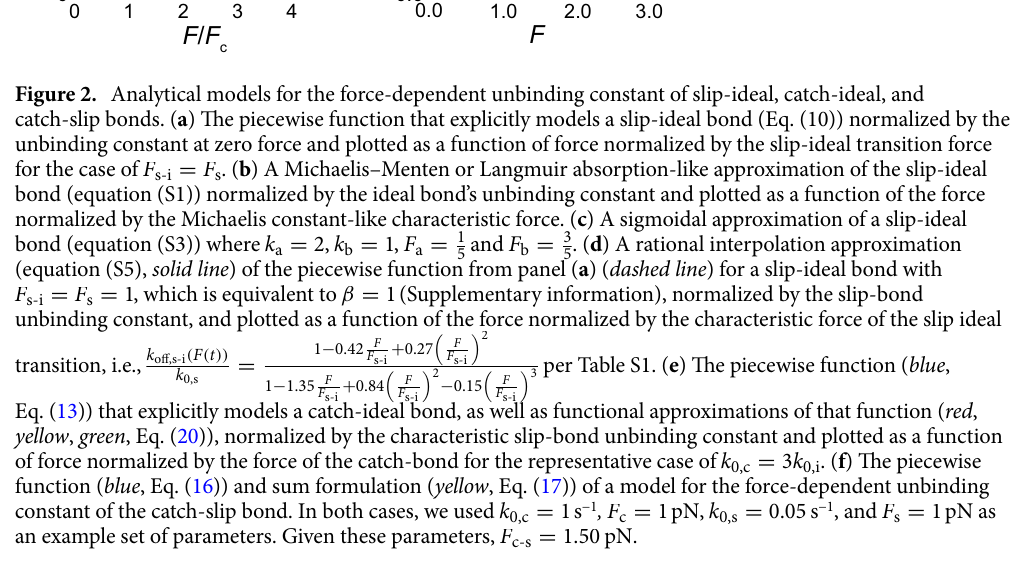
While there appear to be four independent parameters: the ideal bond’s unbinding constant, the slip bond’s unbinding constant and force sensitivity, and the slip-ideal transition force, F s-i , they are related by k 0,i = k 0,s e or equivalently F s-i = α F s where α = ln k 0,i k , due to the continuity condition at F = F s-i . Thus, the slip-ideal model 0,s